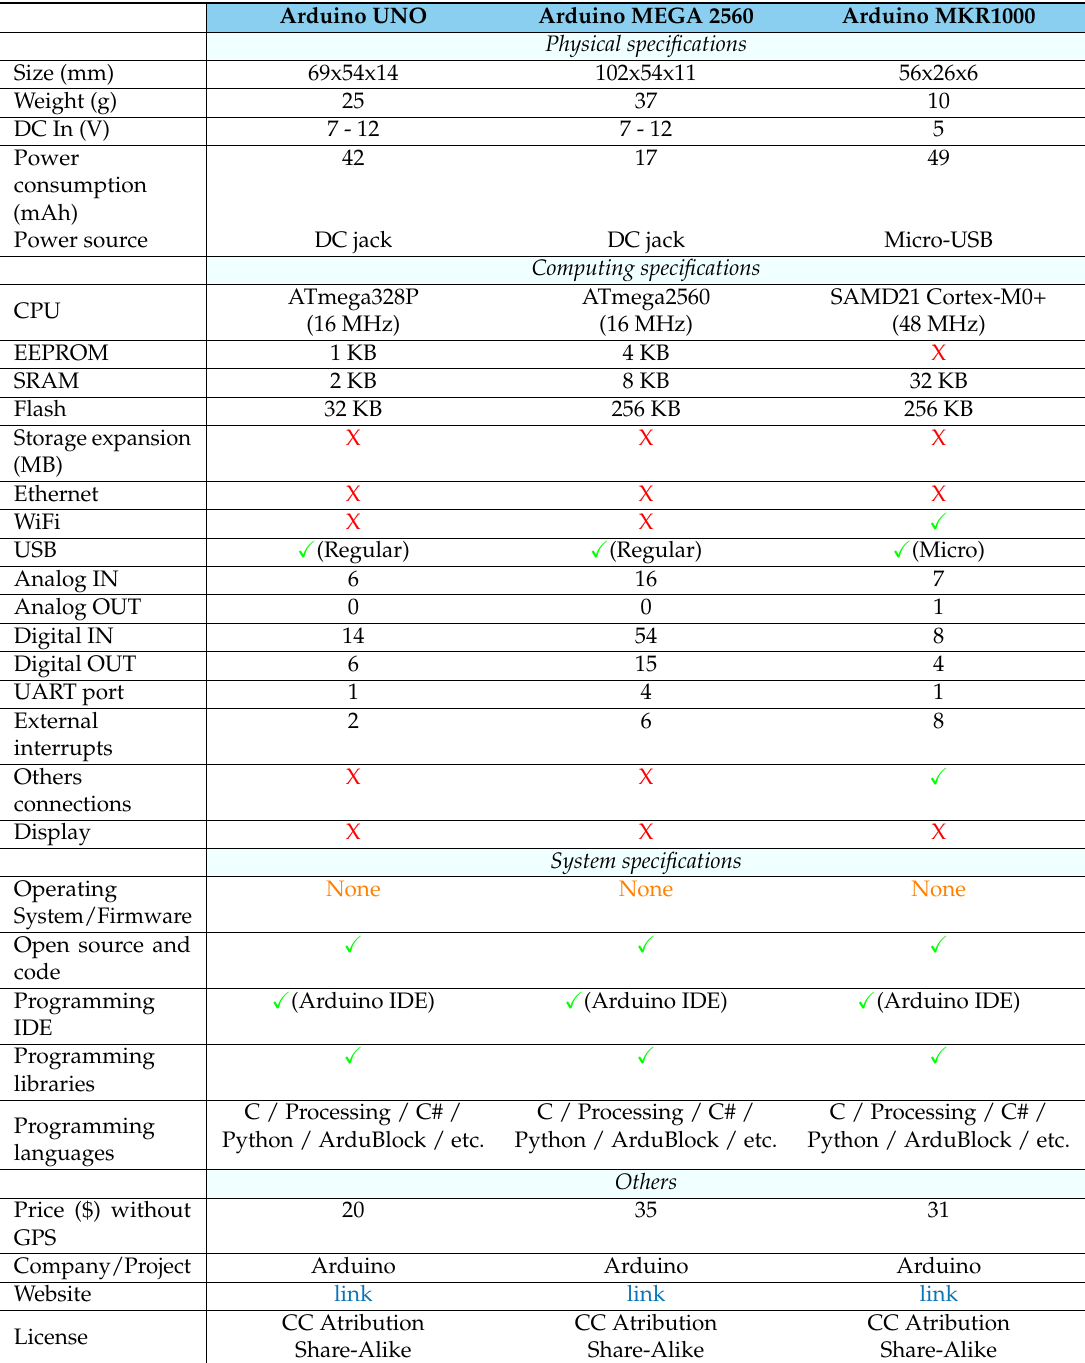
Table 10. Autopilot